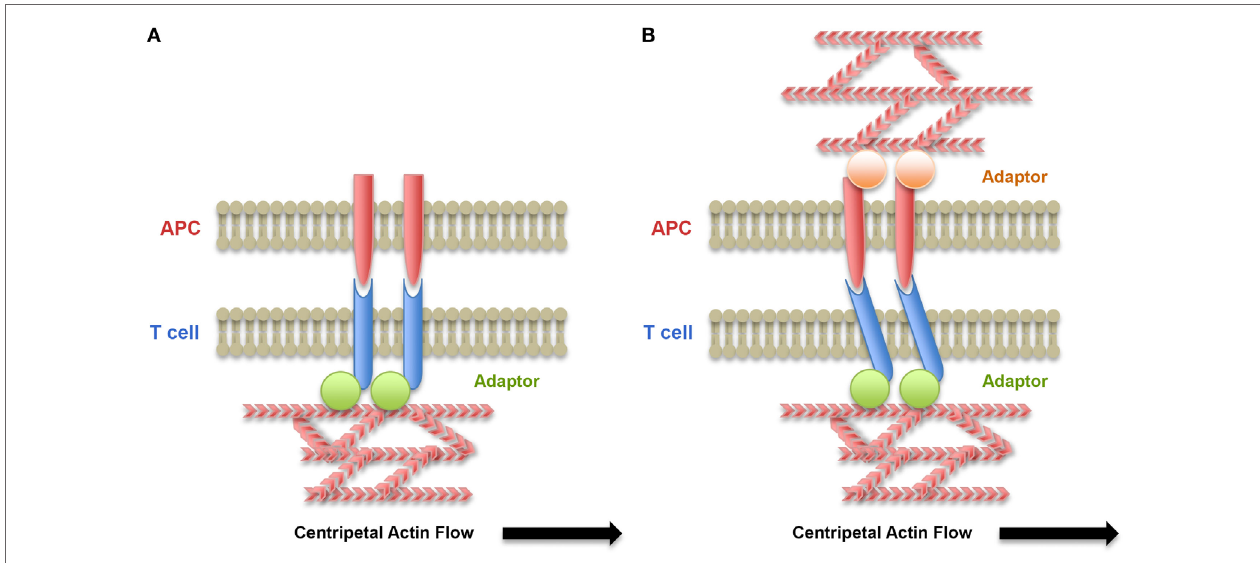
FiGURe 2 | Role of the cytoskeleton of the T lymphocyte and the APC on force exertion on receptor/ligand bonds . (A) Centripetal flow of actin exerts forces on receptor/ligand bonds when receptors are coupled by an adaptor to the cytoskeleton. These forces may lead to conformational changes of the receptors and signaling. (B) When ligands are associated with the APC cytoskeleton, forces on receptor/ligand bonds are submitted to resistance due to reduced mobility of the ligands on the APC surface and the forces exerted on bonds are